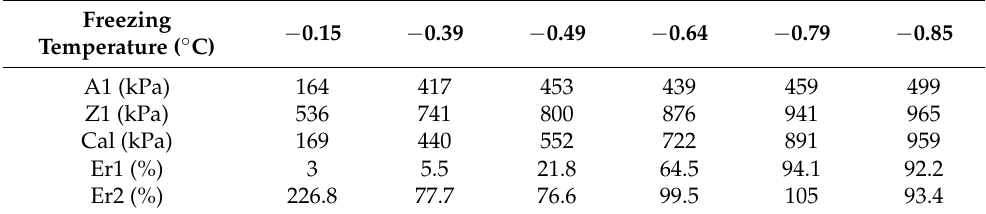
Table 3. Relationship between the tensile strength of soil in the frozen fringe and freezing